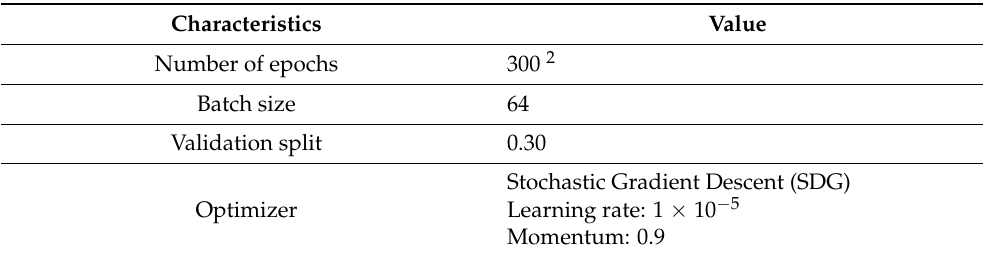
Table 2. Network configuration used for training FCN-DK6, FCN-DK6-i and the Modified FCN-DK6 in this